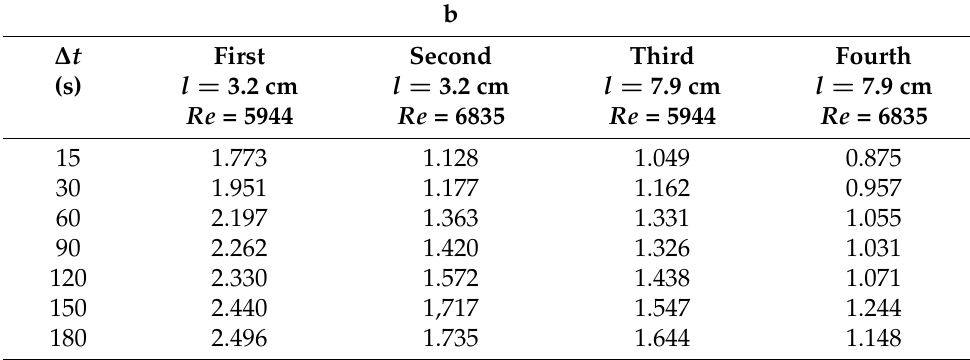
Table 3. Values of scaling exponent of Taylor’s law b for each configuration at several aggregation time